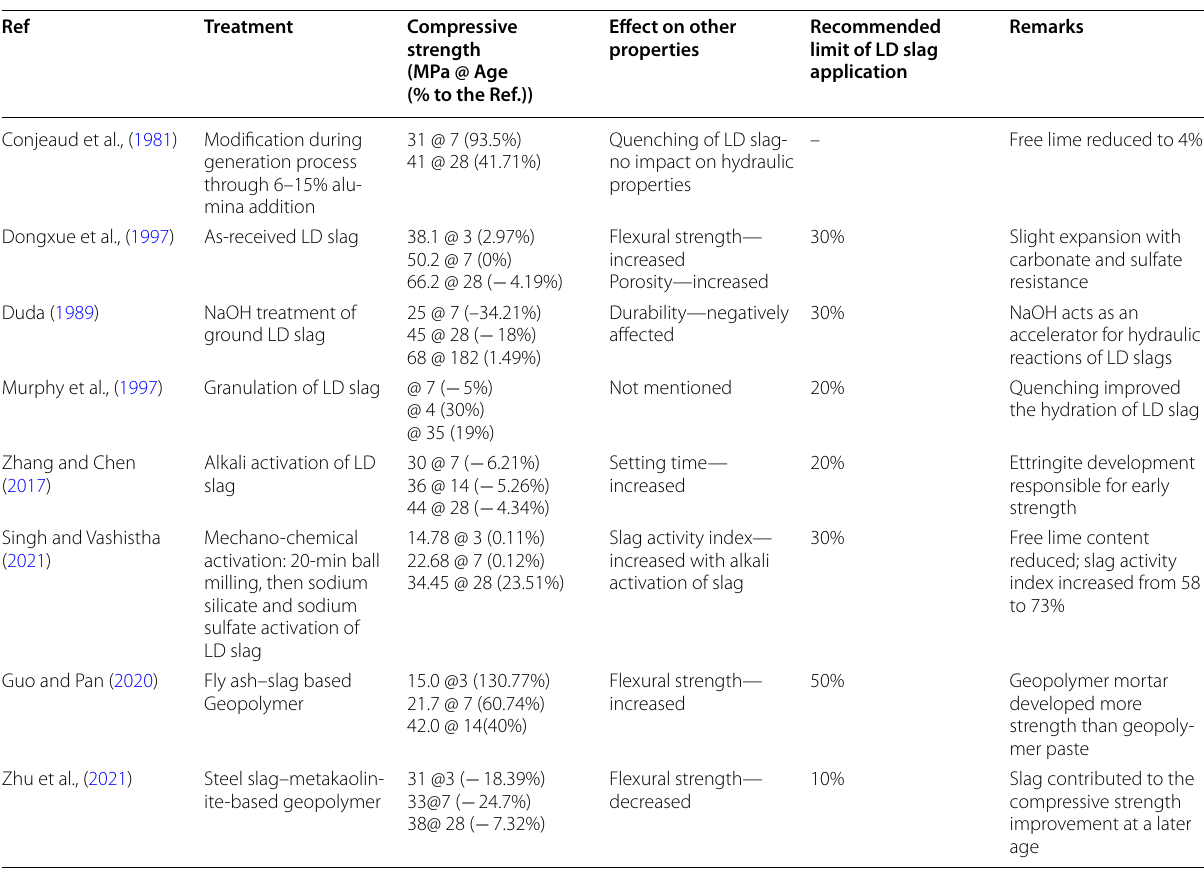
Table 5 LD slag application as a cementitious